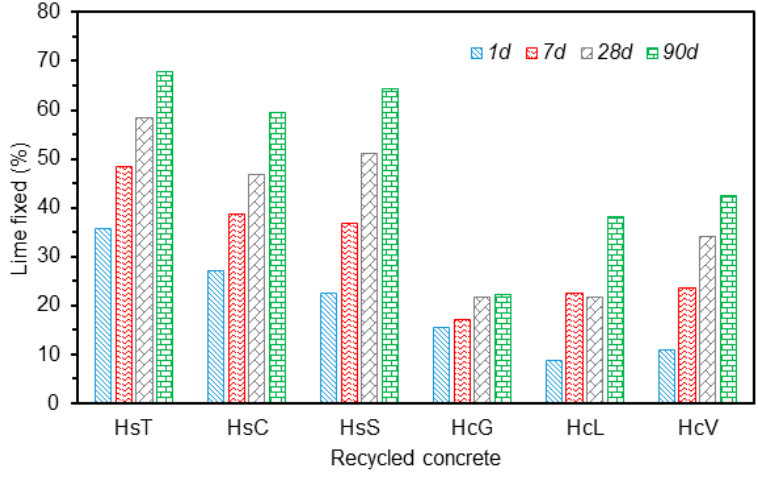
Figure 11. Variation in lime fixed with reaction time.